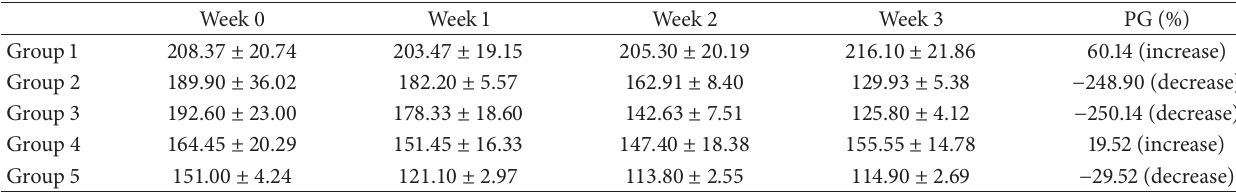
Table 3: Body weights of non-diabetic and diabetic rats (g).